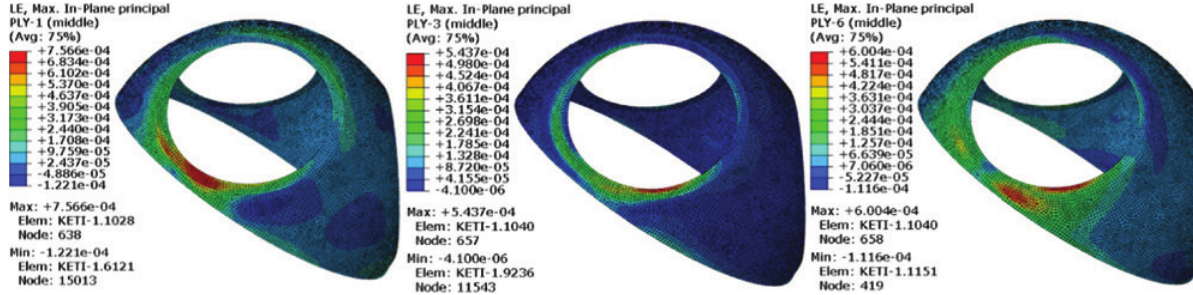
Figure 4: Strain nephogram of spherical shell’s first, third, and sixth layers (tensile